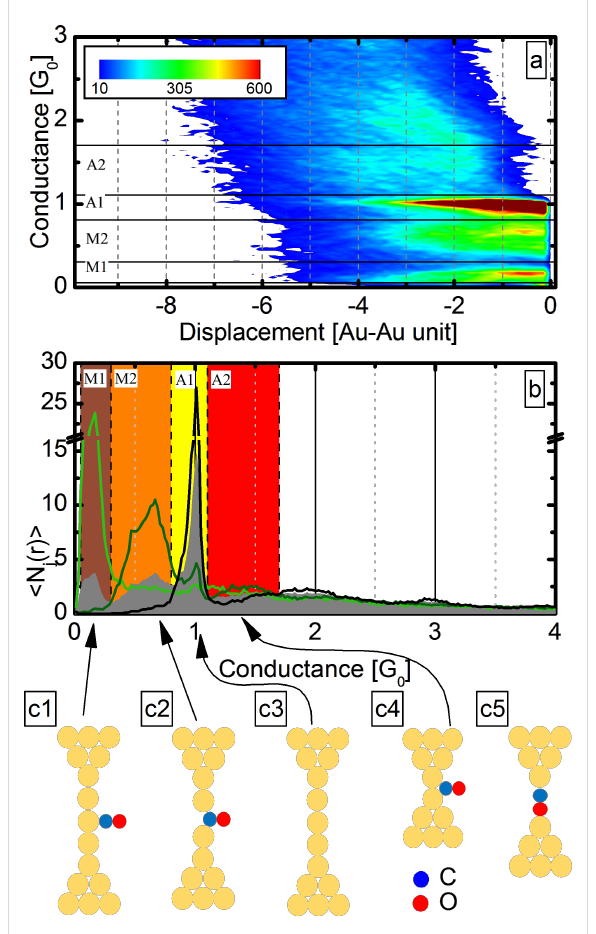
Figure 5: (a) The 2DCDH of all traces with G ref = 0.01 G 0 . This histogram shows that the junction can break from all the three regions (M1–M2, A1). (b) The histograms of selected traces according to the final configuration selection for the M1 region (light green), M2 region (dark green) and the A1 region (black). (c1–c5) Configurations that can be formed during the junction opening: (c1) and (c2) Au atomic chain with a CO molecule bound in an atop and bridge geometry, respective- ly. (c3) Pure Au atomic chain. (c4) Precursor molecular configuration. (c5) A parallel CO molecule is incorporated in the chain. (According to our arguments the latter is not observed in the present